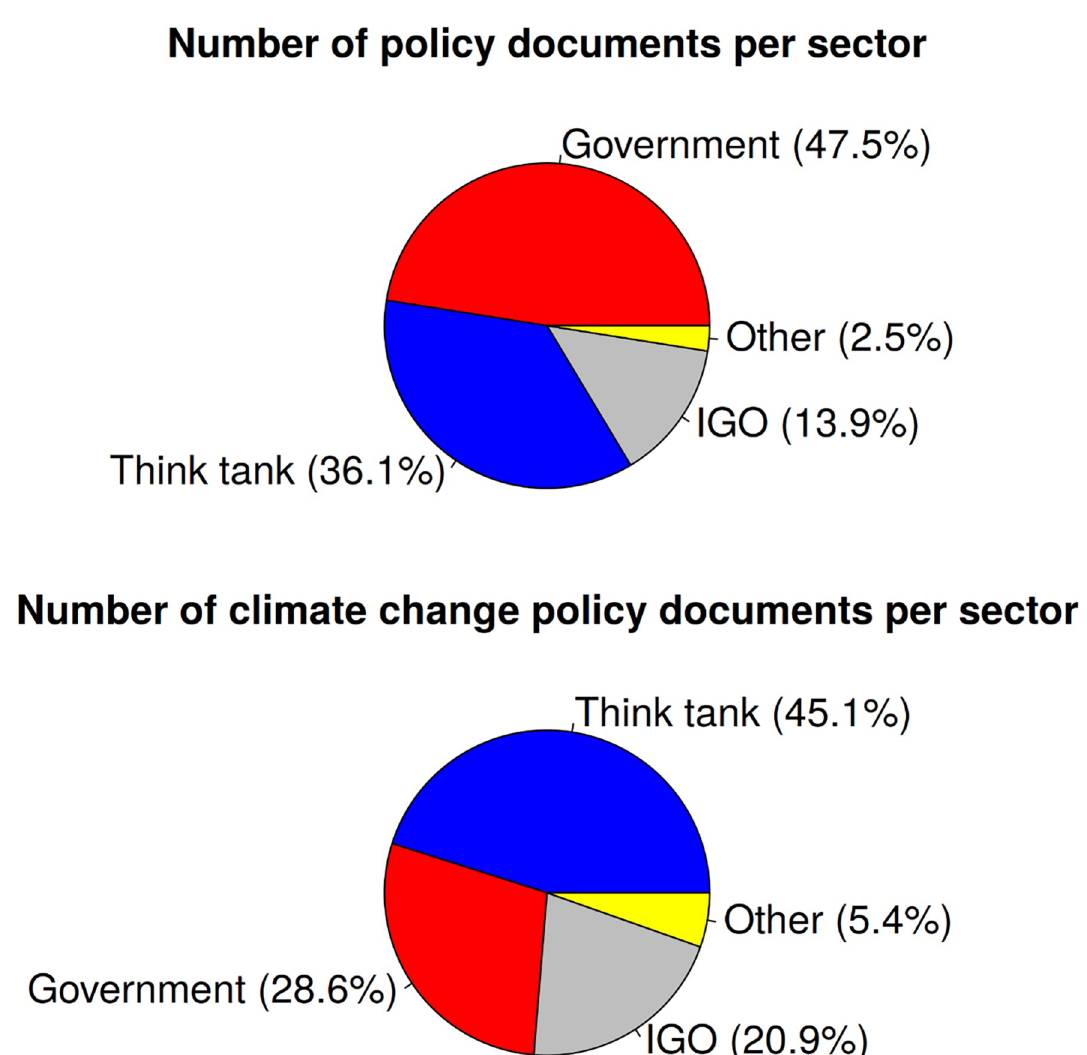
Fig 2. Percentage of (climate change) policy documents per